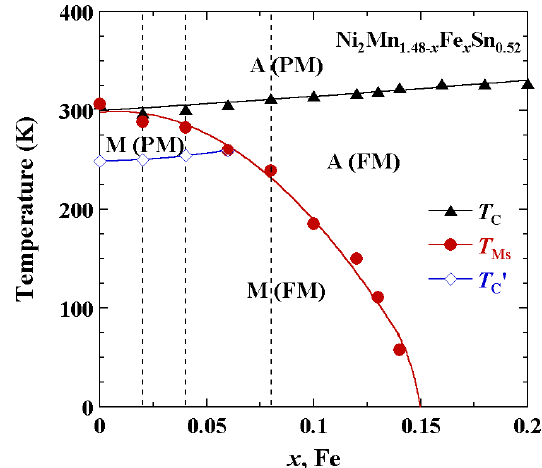
57 Fe Mn Sn ( x = 0.02, 0.04 and 0.08) alloys. 2 1.48 − x x 0.52